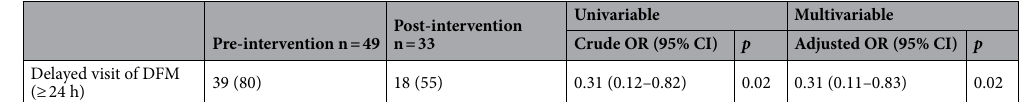
Pre-intervention n = 49